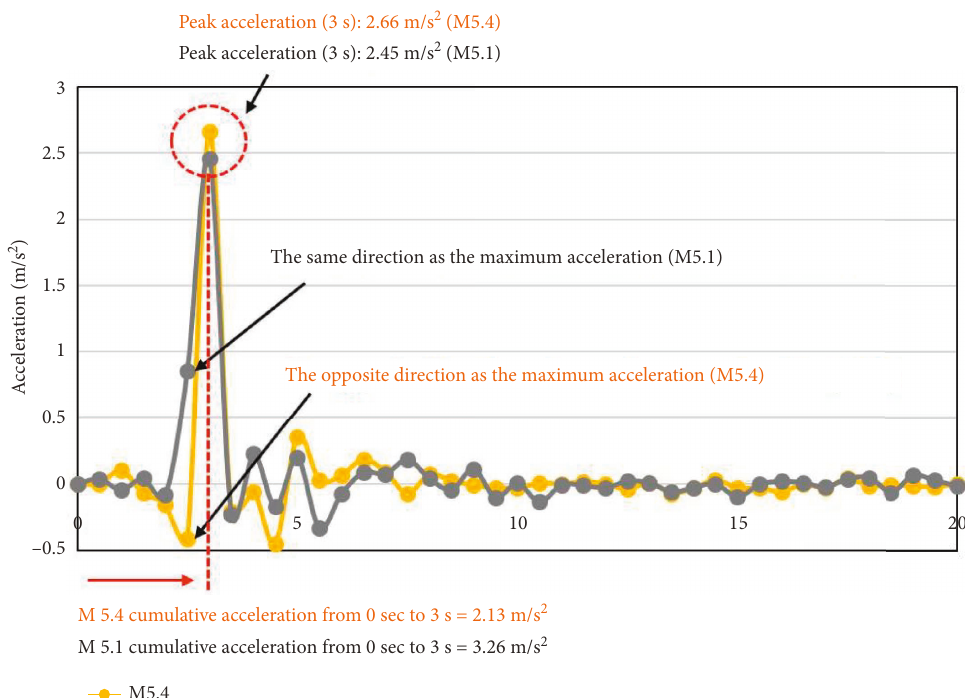
Figure 10: Acceleration graphs for the M5.1 and M5.4 earthquakes. The maximum acceleration of the M5.4 earthquake is higher than that of the M5.1 earthquake. However, the cumulative acceleration of the M5.4 earthquake is lower than that of the M5.1 earthquake due to acceleration being in the opposite direction just before the